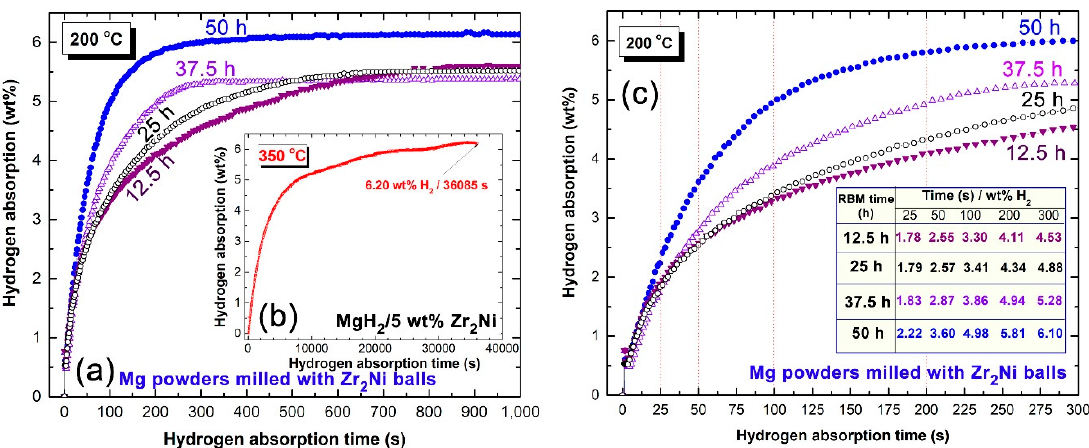
Figure 10. ( a ) Hydrogenation kinetics, measured at 200 °C under 10 bar of hydrogen for MgH 2 powders milled with Zr 2 Ni balls after different RBM times, and (b) hydrogen absorption kinetics, measured at 350 °C under 30 bar of hydrogen of MgH 2 doped with Zr 2 Ni powders and milled for 50 h. The hydrogenation behaviors of the samples shown in ( a ) are demonstrated in ( c ) with a different scale of absorption time.